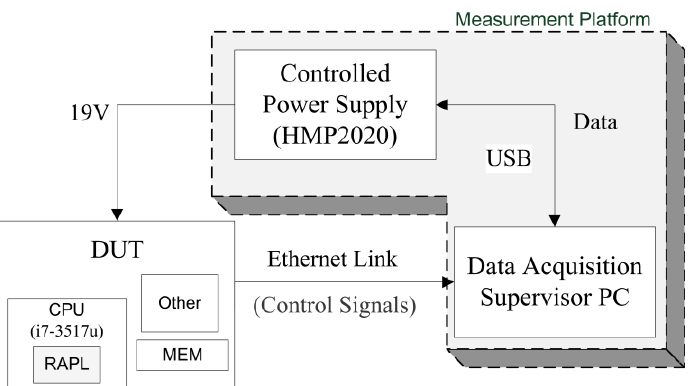
Figure 3. Measurement Testbench.